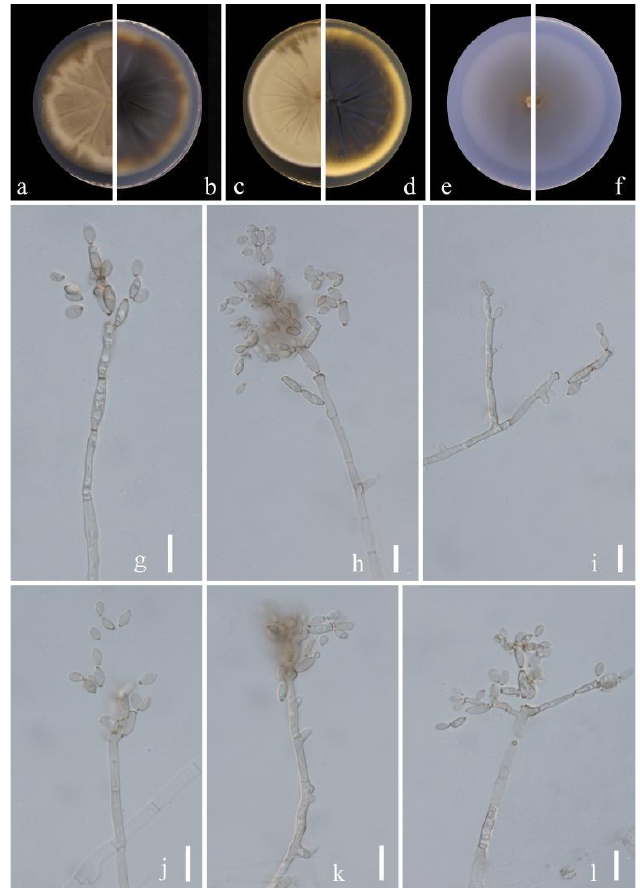
Figure 7. Cladosporium nayongensis (HGUP 21260, holotype). ( a , b ) Culture on PDA from above and reverse. ( c , d ) Culture on MEA from above and reverse. ( e , f ) Culture on SNA from above and reverse. ( g – l ) Conidiophores, secondary ramoconidia and conidia on SNA. Scale bars = 10 µm. Sexual morph: Not observed. Asexual morph: hyphomycetous. Mycelium superfi- cial and immersed, hyphae unbranched or sparingly branched, septate, sometimes con- stricted at septa, especially in wider ones, subhyaline to pale olivaceous or pale olivaceous